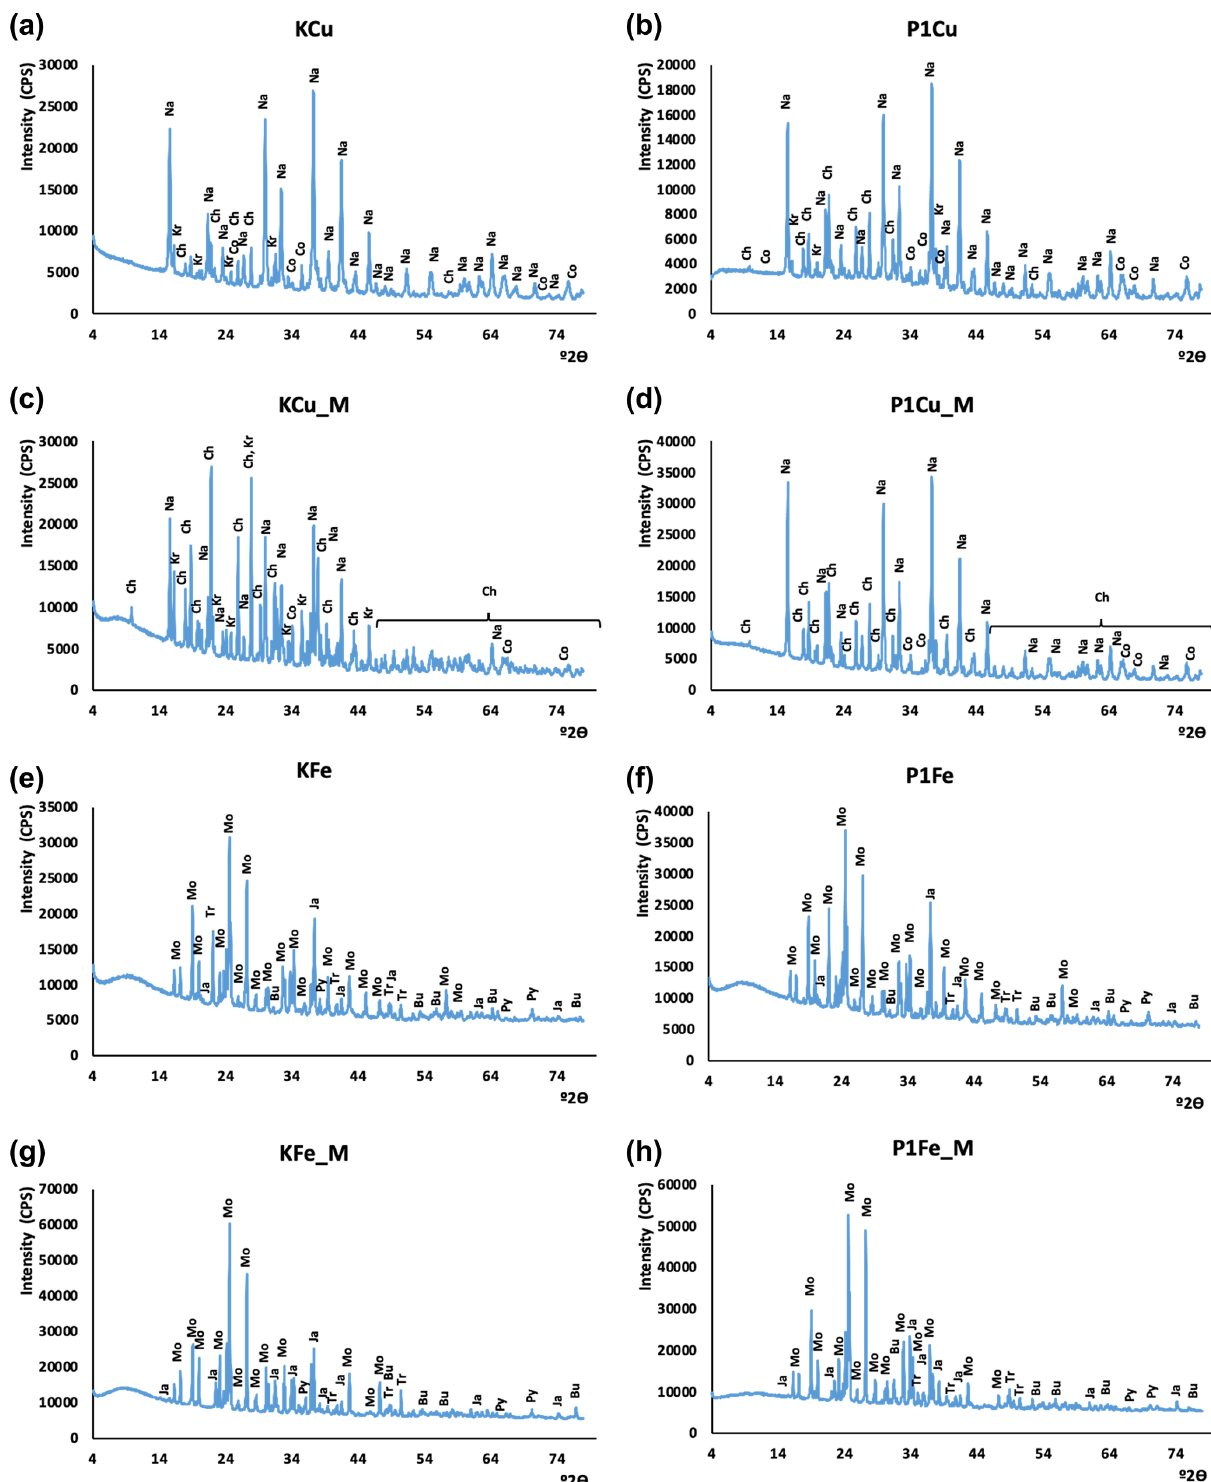
Figure 4. XRD patterns of synthesized minerals. The CuS experiment without mixing: (a) control experiment; (b) P1 phage experiment. The CuS experiment with mixing: (c) control experiment, (d) P1 phage experiment. The FeS experiment without mixing: (e) control experiment, (f) P1 phage experiment. The FeS experiment with mixing: (g) control experiment, (h) P1 phage experiment. Oxidation products: Bu – butlerite, Ch – chalcanthite, Kr – kröhnkite, Na – natrochalcite, Ja – jarosite; substrates: Mo – mohrite; sulfides: Co – covellite, Tr – troilite(?), Py –